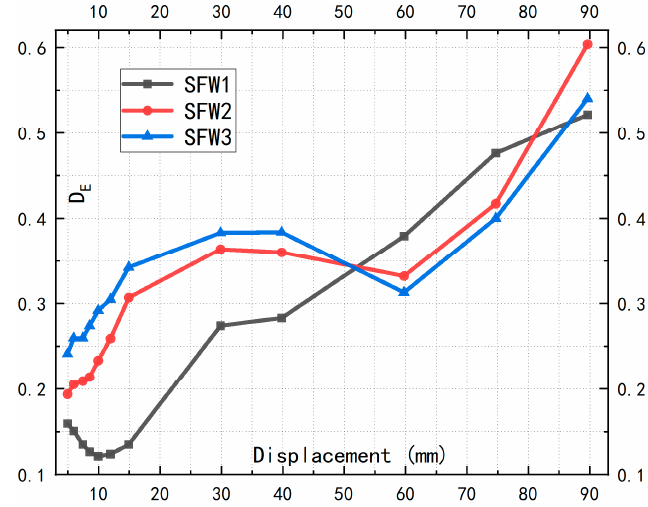
Figure 15. Energy-dissipating capacity (D E ) of specimens.